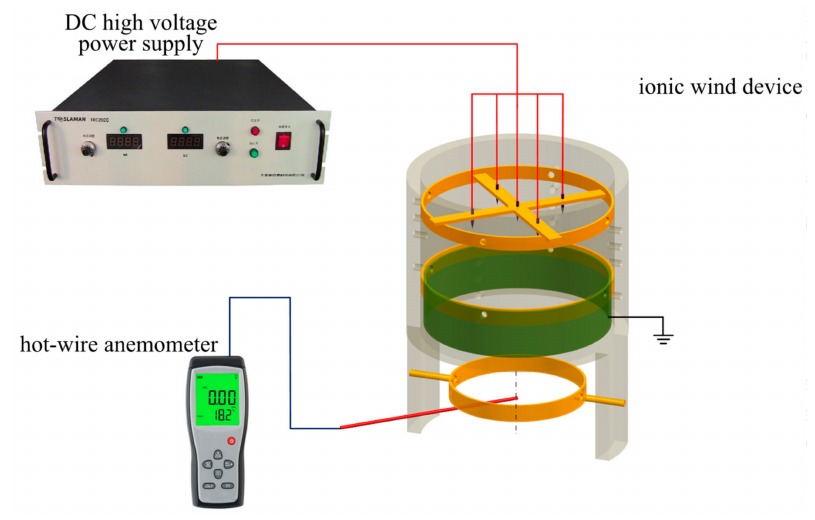
Figure 4. Schematic of the ionic wind velocity testing